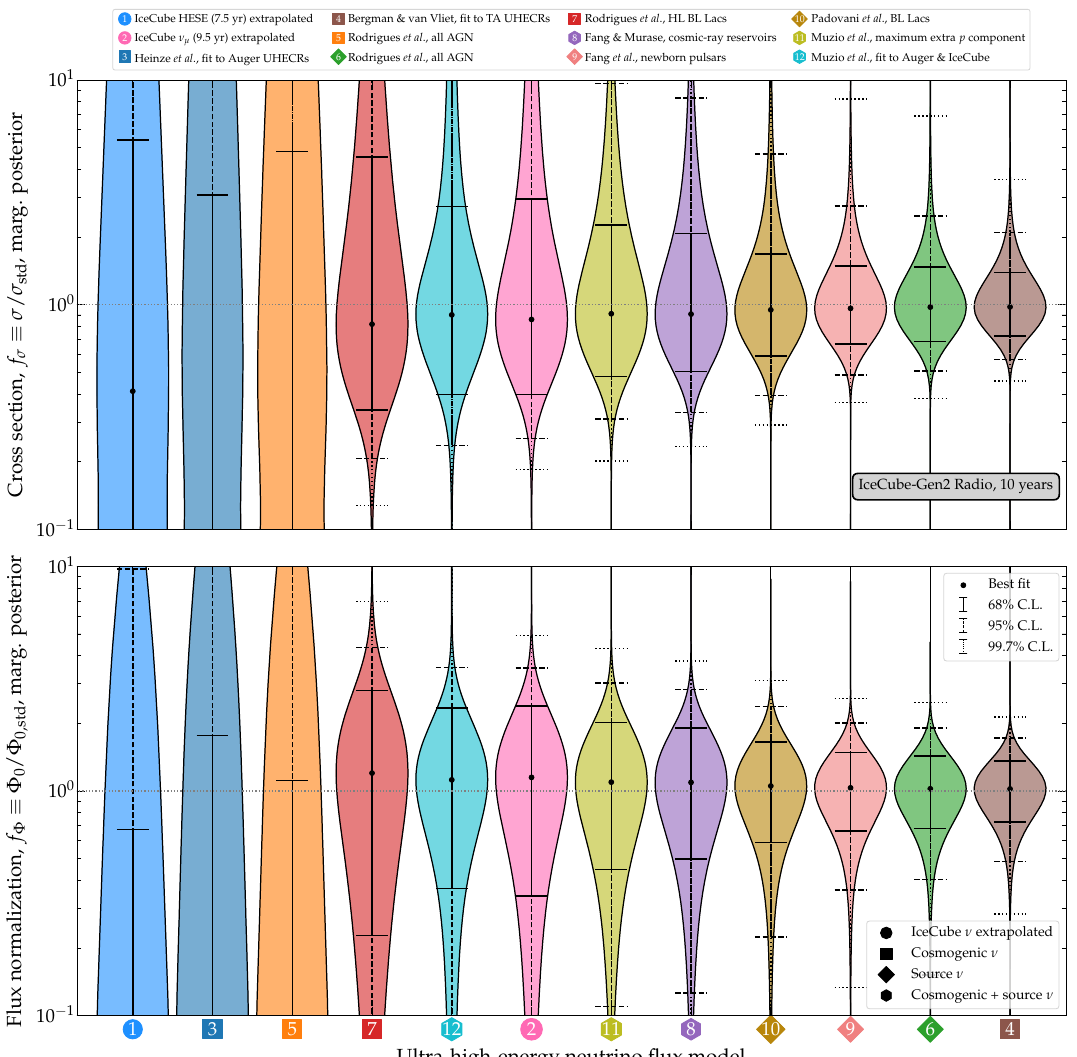
Figure 23 . One-dimensional marginalized posteriors of the UHE νN cross section, f σ , and the UHE neutrino flux normalization, f , for all the benchmark UHE neutrino flux models adopted Φ in our analysis. See figure 22 for the corresponding two-dimensional posteriors and table 2 for numerical